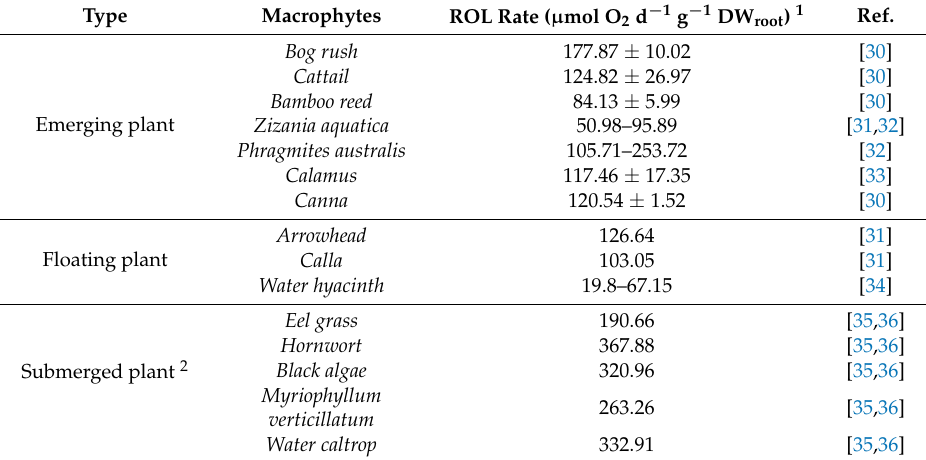
Table 1. ROL rate of different